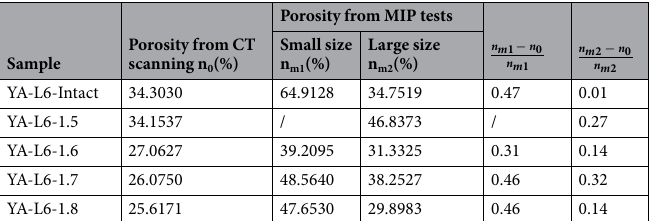
—the percentage of connected pores (%). N c